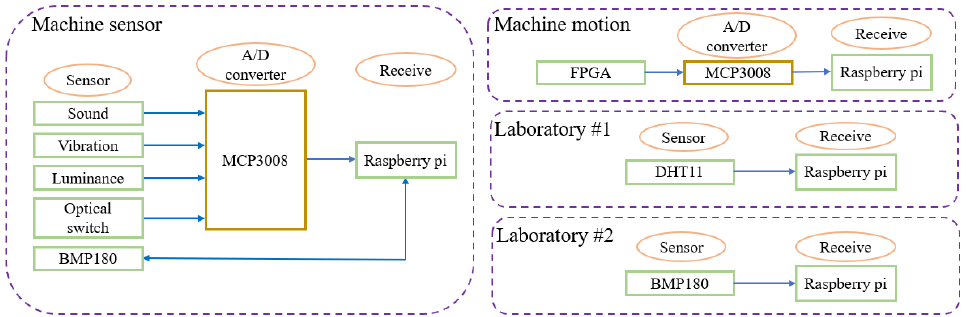
Figure 8. Physical connection of sensor and Raspberry Pi.